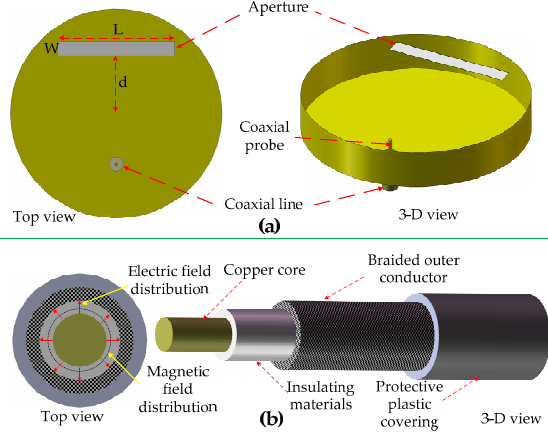
Figure 2. ( a ) Top and 3-D view of the integrated aperture/resonator with coaxial line; ( b ) Field distribution and configuration of the coaxial line.